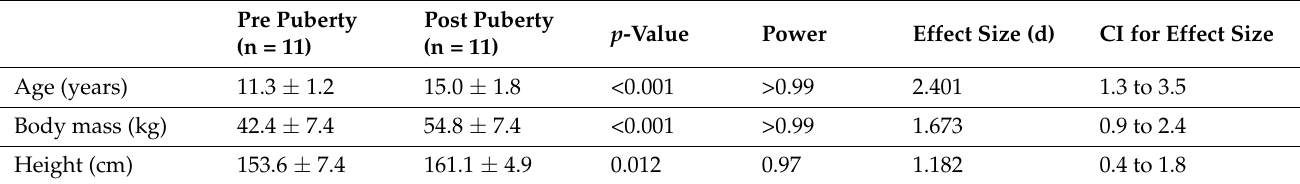
Table 2. Anthropometric data of the girls in the study.